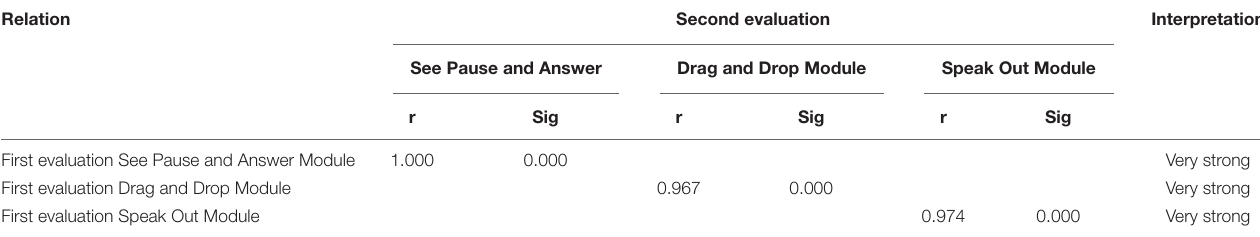
TABLE 4 | Pearson’s correlation coefficient index r ME-CoT Visual Studio. Relation